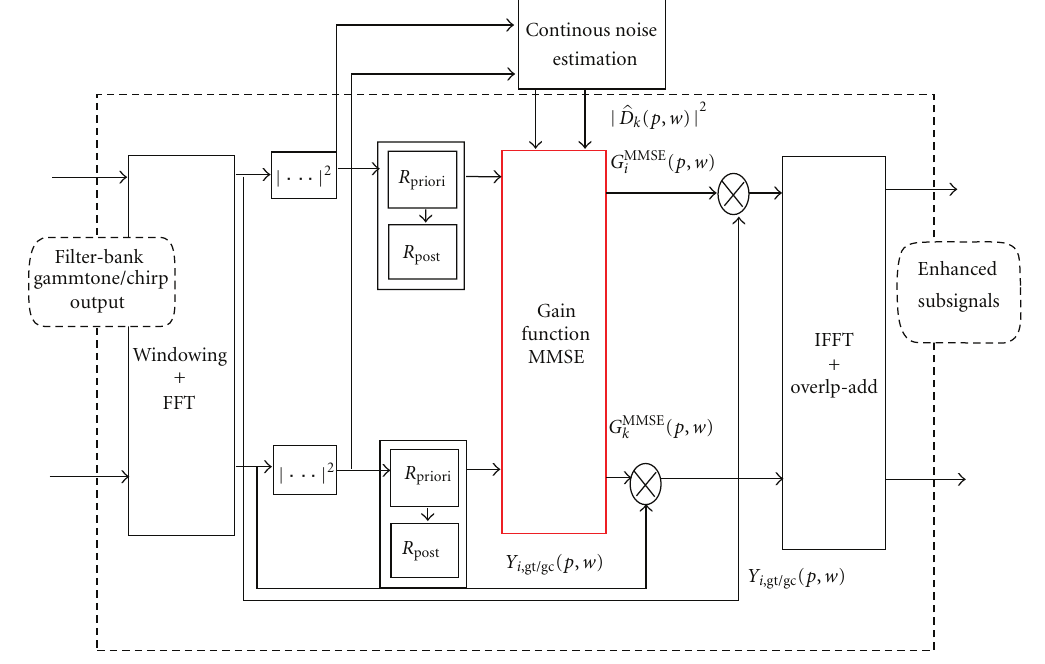
Figure 4: Perceptual MMSE spectral modification technique applied in multirate